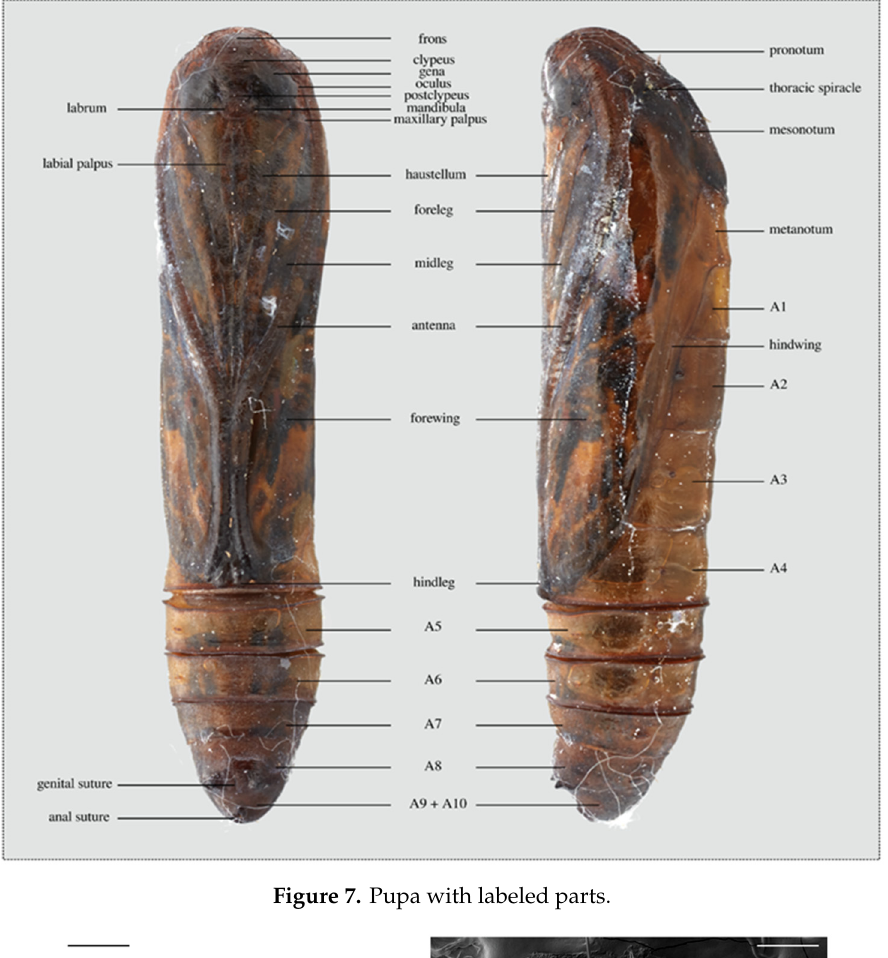
Figure 7. Pupa with labeled parts.